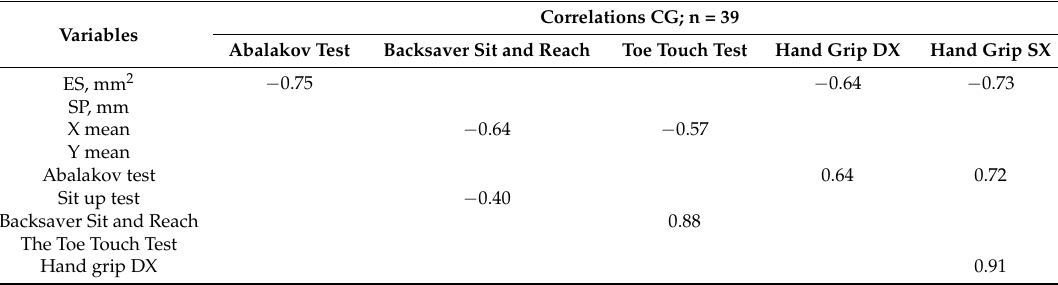
Table 3. Description of the correlations between variables of CG